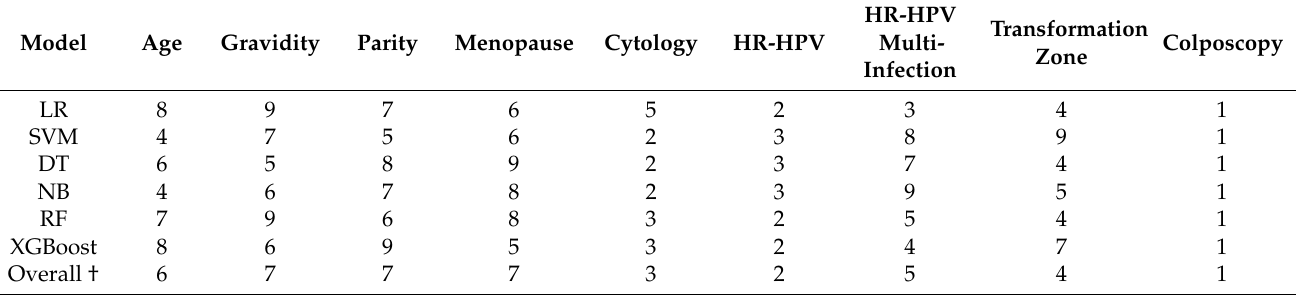
The number 1 indicates that the variable ranks first in terms of importance, and 9 indicates that the variable ranks last among all variables. † The overall-importance of the variable is obtained by averaging the variable ranking in six models. Abbreviations: HR-HPV, high-risk human papillomavirus; LR, logistic regression; SVM, support vector machine; DT, decision tree; NB, naïve bayes; RF, random forest; XGBoost, extreme gradient